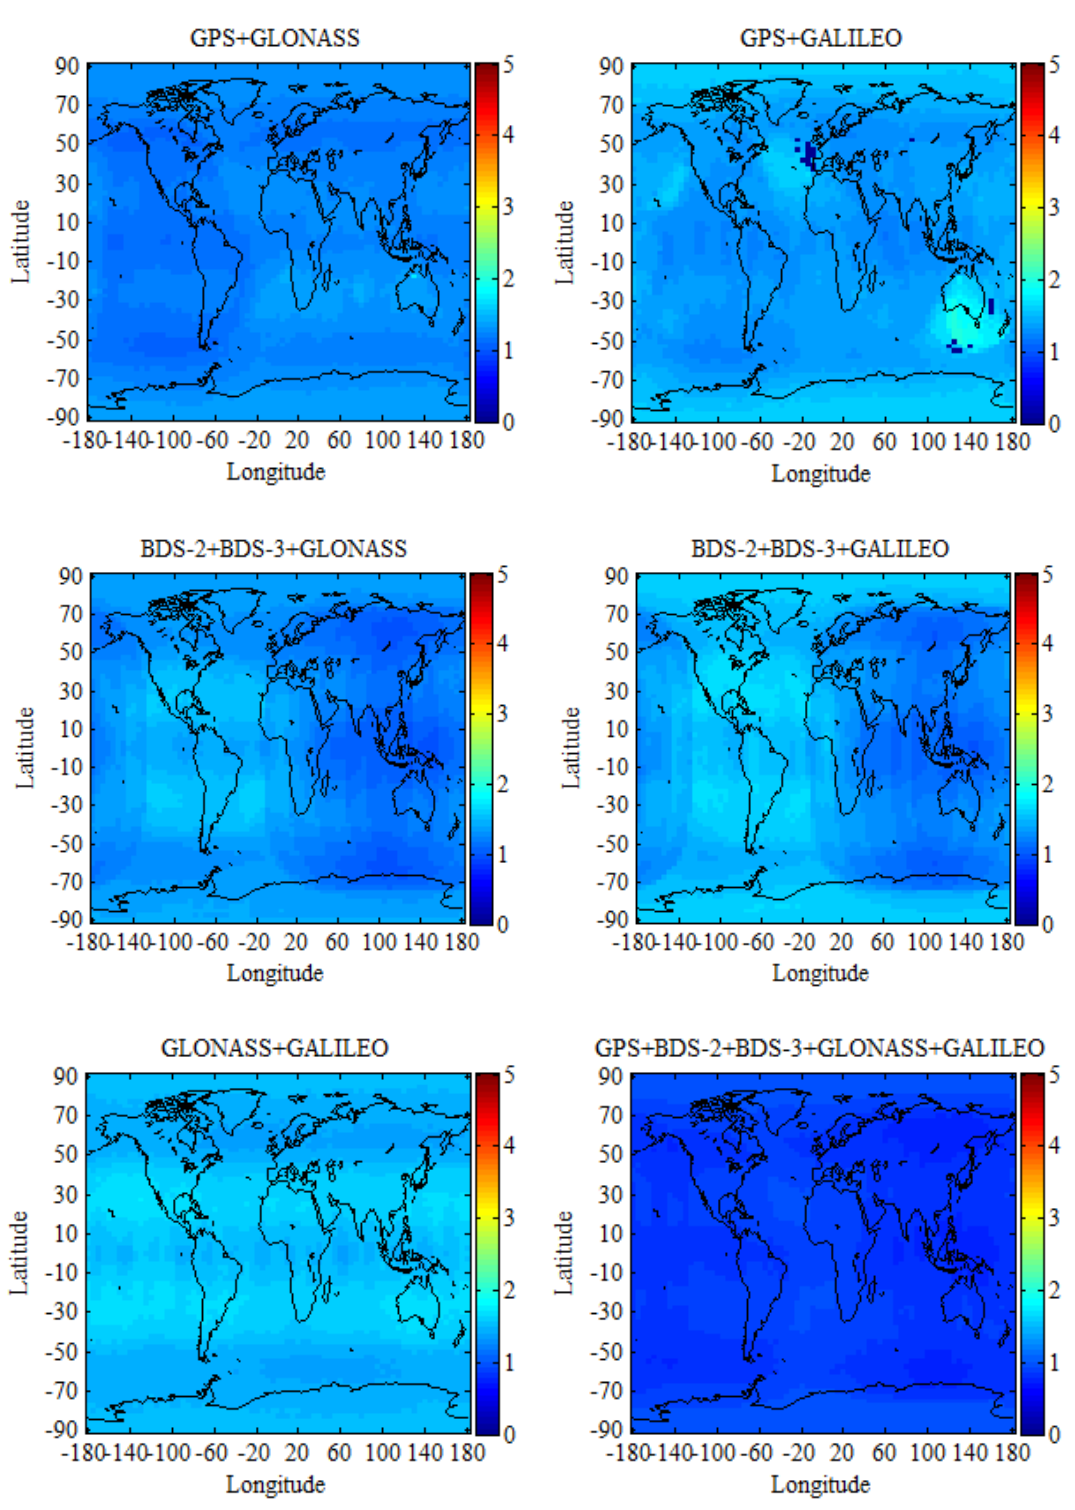
Figure 2. The global mean Position Dilution of Precision (PDOP distribution for GPS, BDS-2, BDS-2 / BDS-3, GLONASS, Galileo, and multi-GNSS constellations on DOY 024, 2019, with the elevation cutoff of 7.5°.